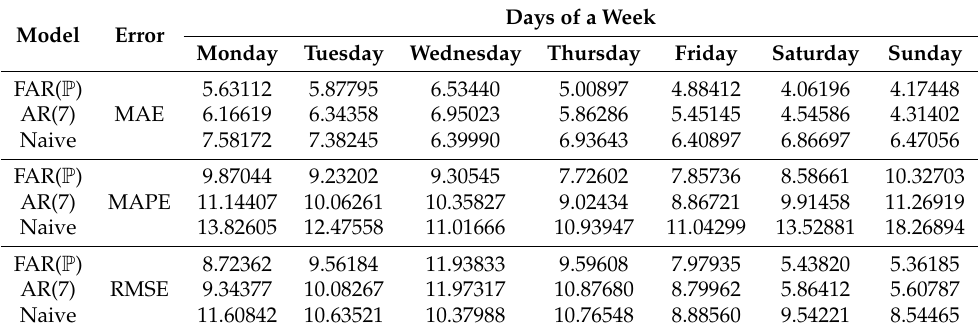
Table 2. IPEX electricity prices: daily forecast errors for FAR( P ), AR(7), and naïve models. Model